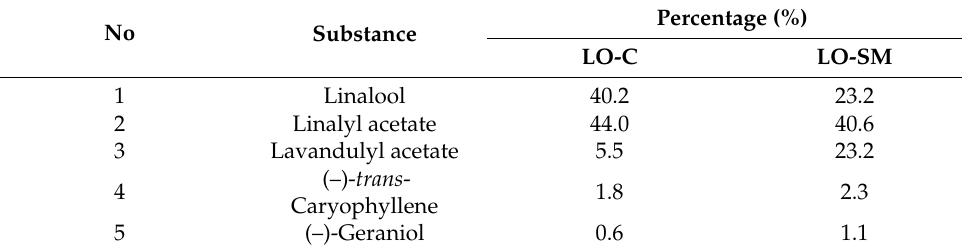
Table 2. Percentage ( w/w ) of individual substances in the analyzed oil